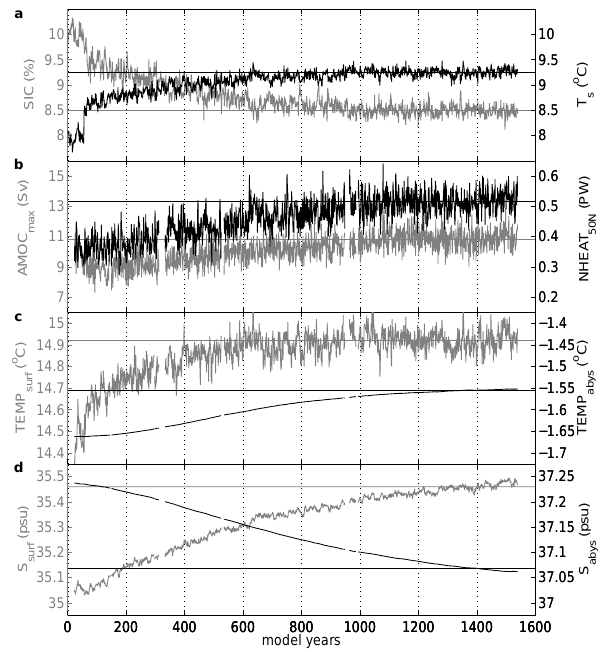
Fig. 1. Annual mean timeseries for the GS12 simulation. (a) Global mean sea ice concentration (SIC) and T s , (b) maximum of the AMOC streamfunction and the oceanic northward heat transport at 50 ◦ C, (c) volume-averaged temperature of the upper 50m and the abyssal ocean (below 2000m depth), (d) volume-averaged salinity of the upper 50m and the abyssal ocean. The mean of the last 300 yr of the simulation is shown as a horizontal line for each variable. Gaps in the ocean curves indicate missing data.